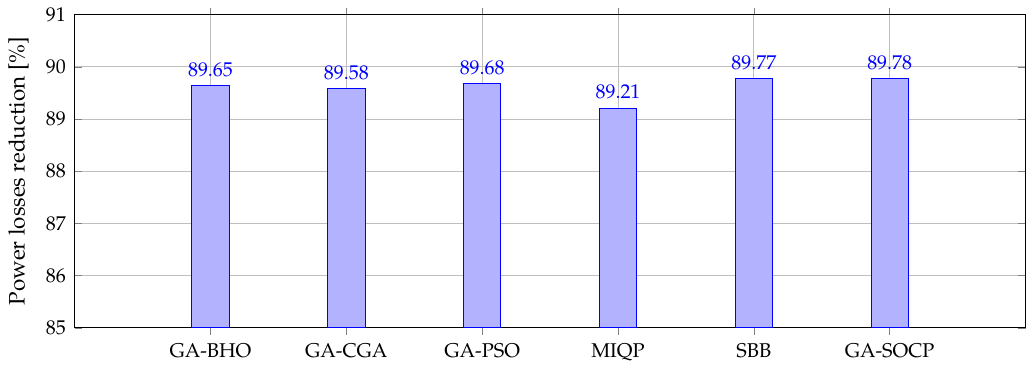
Figure 5. Behavior of the proposed hybrid GA-PSO after 100 consecutive evaluations in the 69-node test feeder.